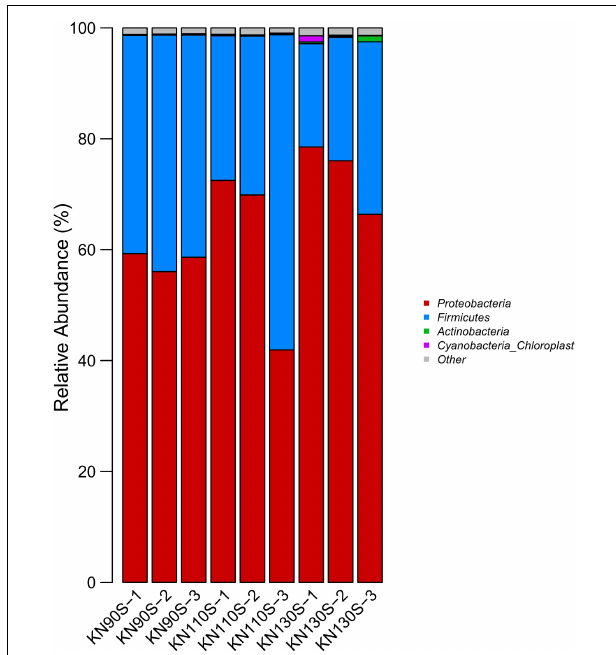
FIGURE 4 | Differences in the bacterial community of king grass silage at the genus level (KN90S, king grass silage harvested at growth periods of 90 days; KN110S, king grass silage harvested at growth periods of 110 days; KN130S, king grass silage harvested at growth periods of 130 days).